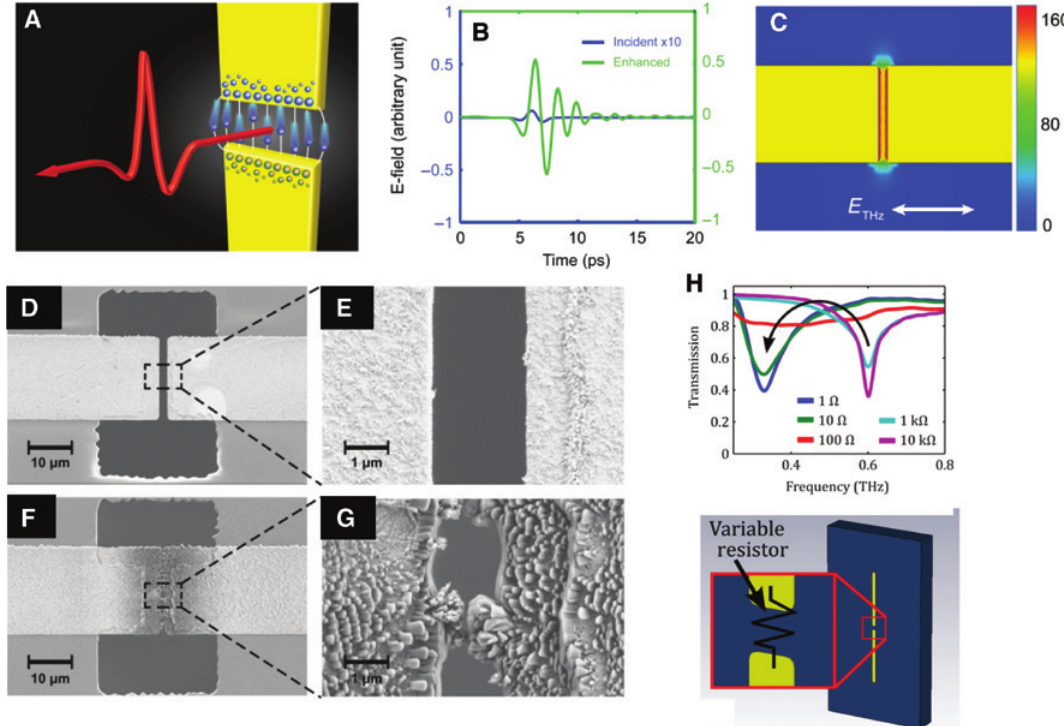
Figure 8: Dipole antenna-based terahertz field–driven electron emission. (A) Illustration of terahertz-induced field emission experiment. The single-cycle strong terahertz pulse enables electrons escape from the gold–vacuum interface. (B) Resonantly enhanced terahertz field in time domain at the gap of dipole antenna. (C) Simulated result of two-dimensional spatial distribution of electric field enhancement. (D–G) SEM images of a dipole antenna gap before (D, E) and after (F, G) strong terahertz field exposure. (H) Transmission spectra for five different resistances identified in the dipole antenna gap. The figures (A–G) and (H) are reproduced from References [27] and [84],